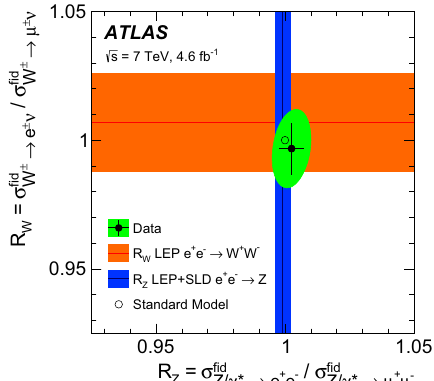
Fig. 16 Measurement of the electron-to-muon cross-section ratios for the W and Z production, R W and R Z . The orange and blue , shaded bands represent the combination of the ratios of electron and muon branching fractions for on-shell W and Z production as obtained at the e + e − colliders LEP and SLC [88,90]. The green shaded ellipse represents the 68% CL for the correlated measurement of R W and R Z , while the black error bars give the one-dimensional standard deviation. The SM expectation of R W = R Z = 1 is indicated with an open circle with R W = 1 . 018 ± 0 . 025 [89] and recently by the LHCb Collaboration with R W = 1 . 020 ± 0 . 019